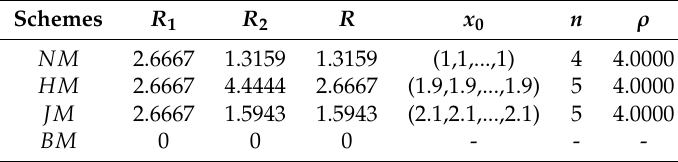
Table 5. Comparison on the basis of different radius of convergence for Example